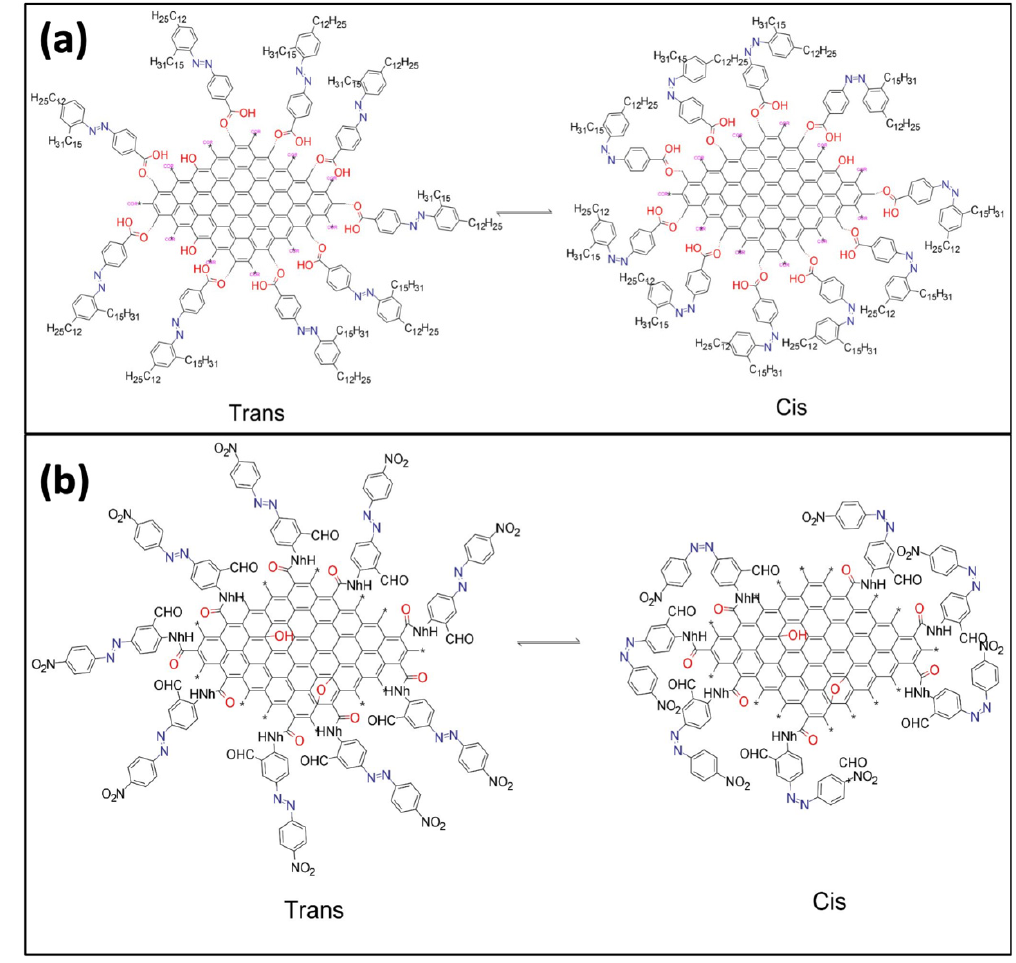
Figure 8. Structure and photoisomerization of ( a ) GQD-AZO and ( b ) GO-AZO composites.